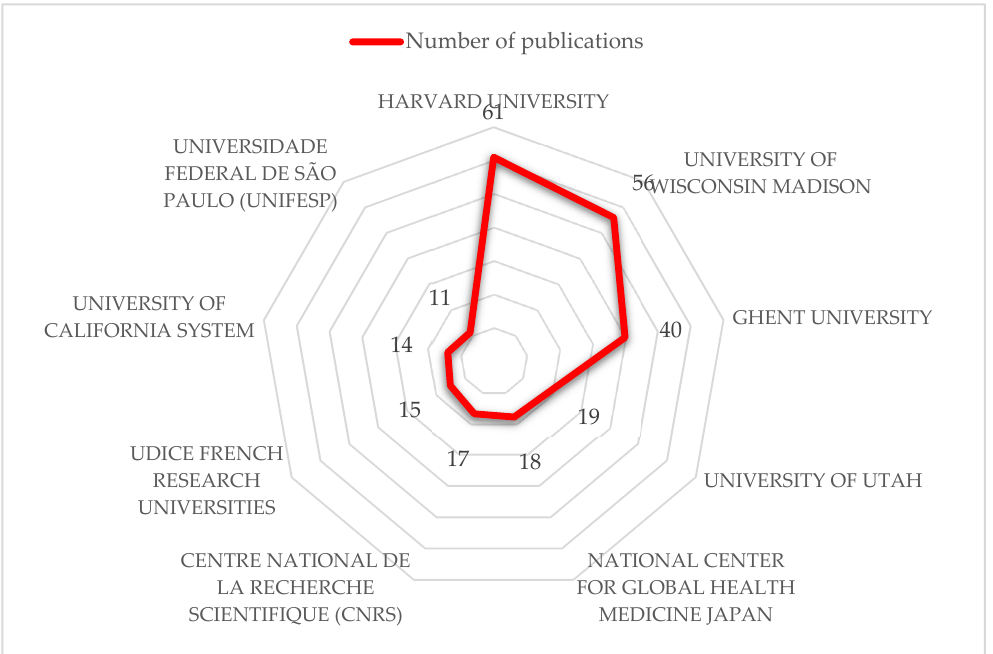
Figure 4. Top 10 institutions with the largest number of publications.